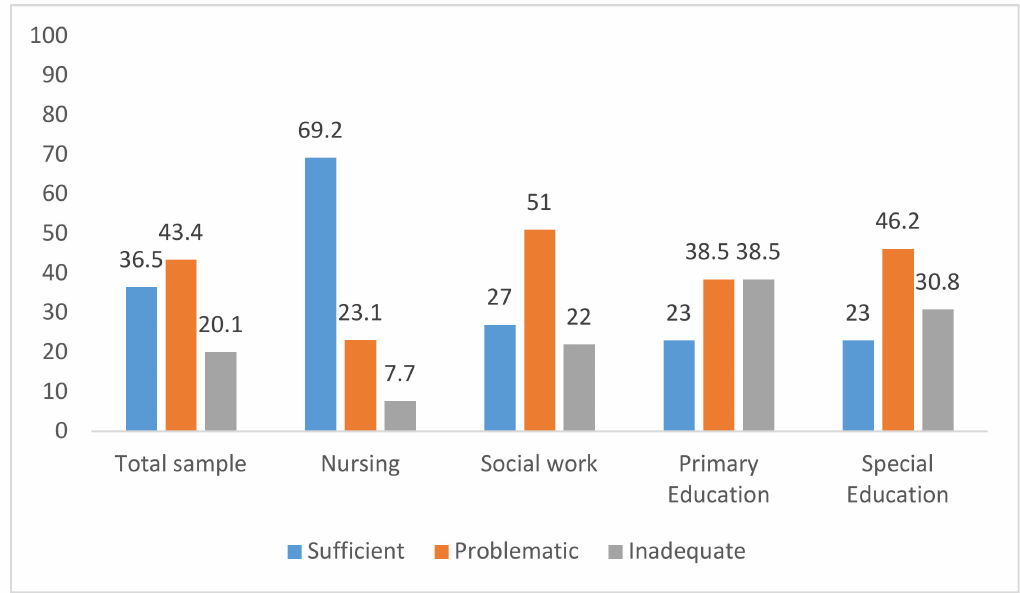
Figure 1. Levels of health literacy index by type of degree and for the total (%). HLS-EU-Q16 index: (score 0–8) Inadequate, (score 9–12) Problematic, and (score 13–16) Su ffi